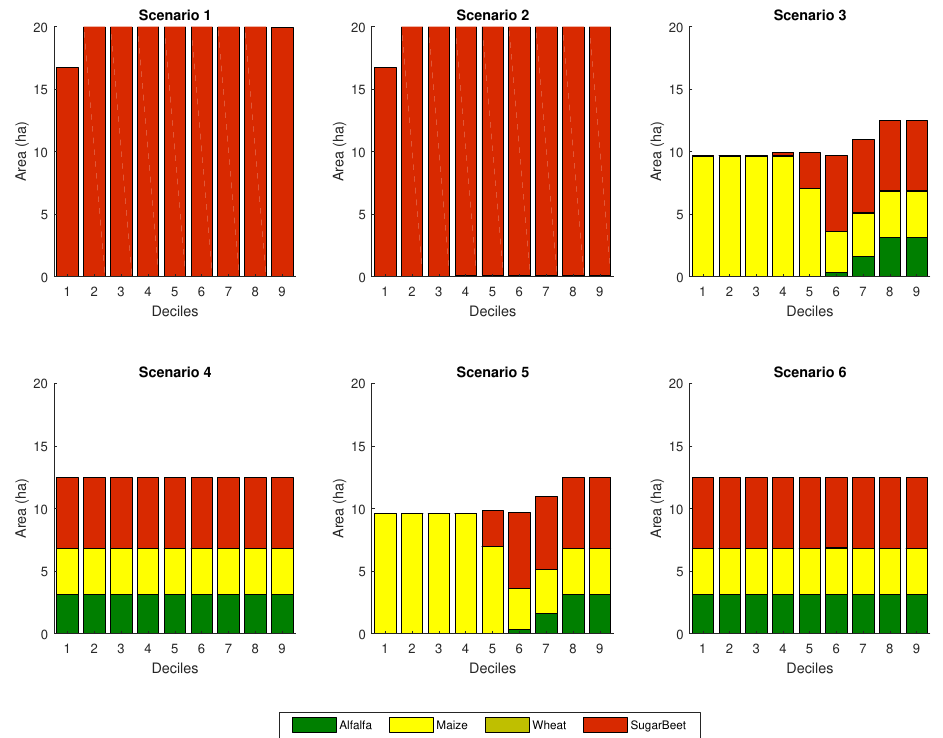
Figure 8. Crop allocation as a result of the optimisation processes for each decile of water supply and for each scenario at the situation a.